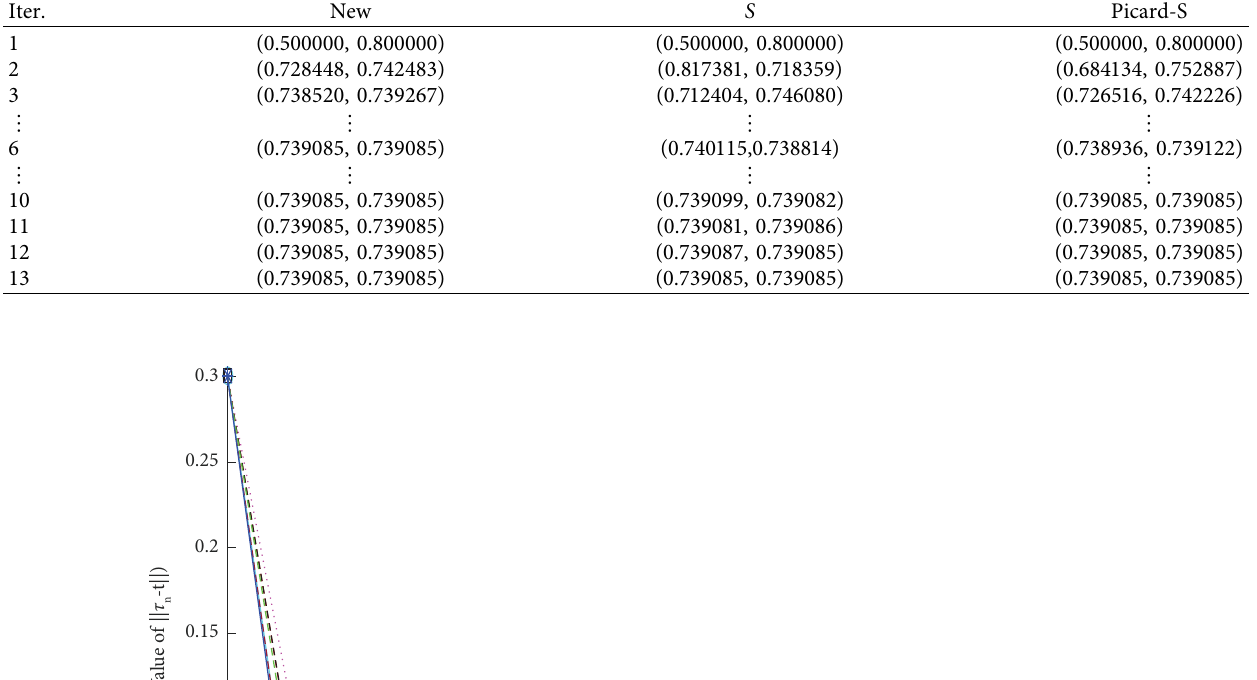
Table 4: A comparison table for the rate of convergence of iterative methods for Example 2.